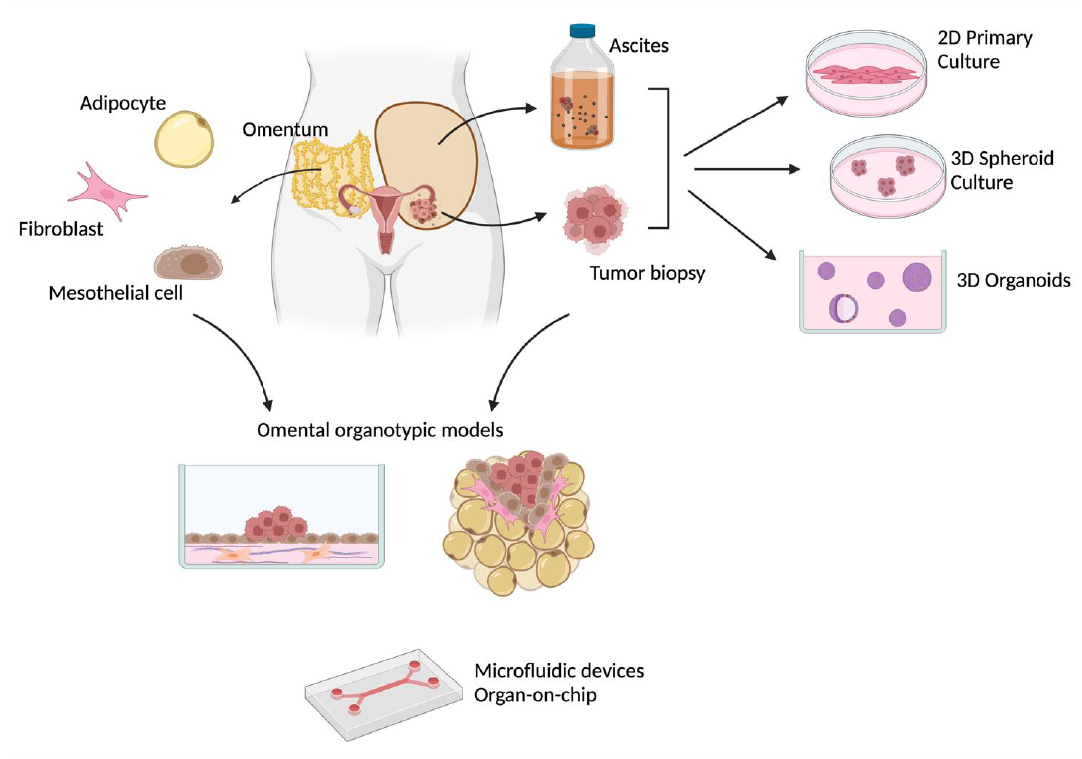
Figure 1. Different patient-derived in vitro models of ovarian cancer. Created with BioRender.com (accessed on 29 November